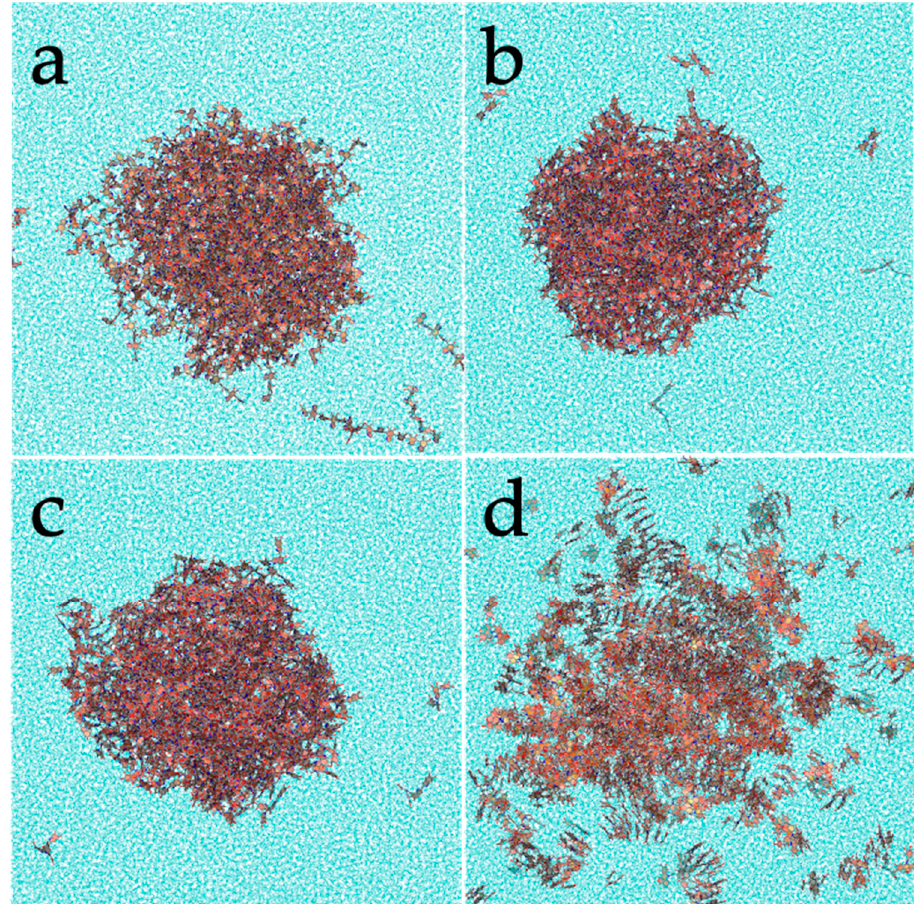
Figure 3. Representation of one configuration for the different PDA models: ( a ) l DHI, ( b ) TET-1, ( c ) TET-2, and ( d ) PYR, in solution from the MD simulations.